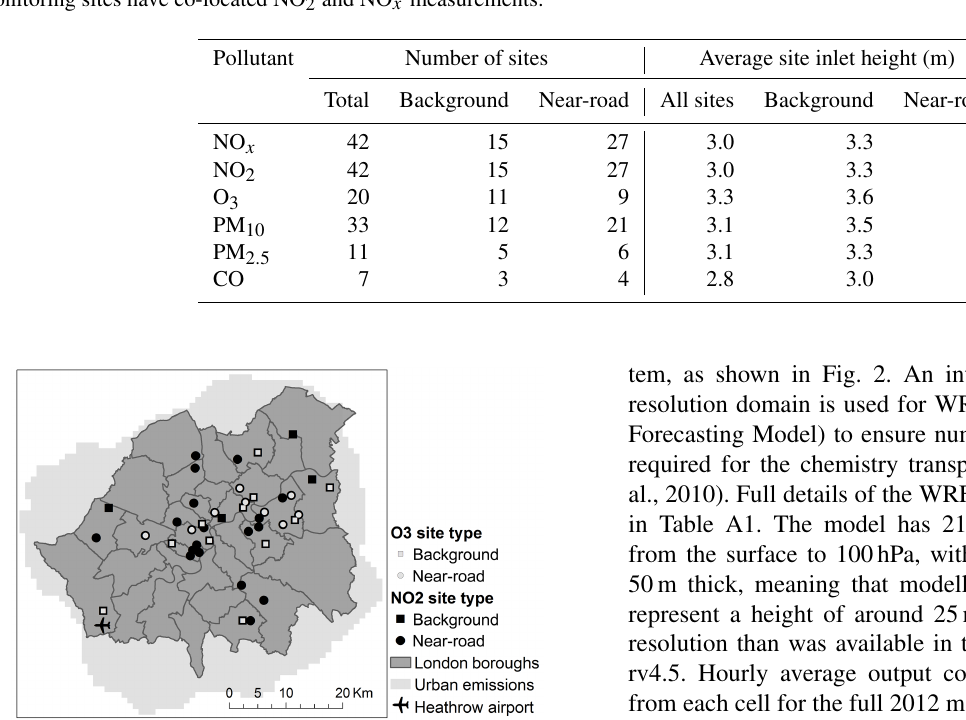
Table 1. Number of monitoring sites per pollutant and site type, with average heights over all sites and by site type. “Background” includes both suburban and urban background sites while “near-road” includes sites classified as roadside and kerbside. Note that all the selected O 3 monitoring sites have co-located NO 2 and NO x measurements.